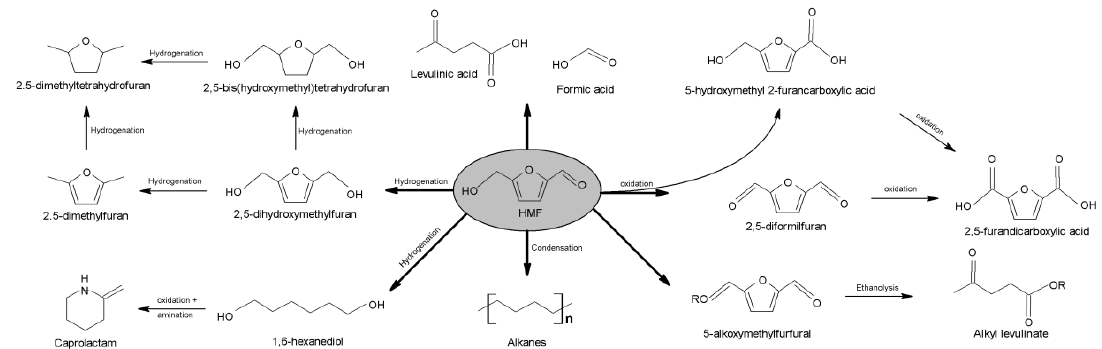
Figure 28. Scheme showing possible reactions of 5-hydroxymethylfurfural to obtain high value-added products.